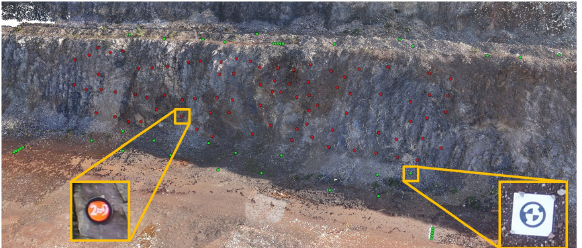
Figure 7: The reference point network allows an extensive accu- racy evaluation. Systematic deformations of the image block and reconstructed object geometry can be quantified. Markers (bot- tom right) indicating GCP positions are shown in green, circular targets (left) for quantitative evaluation are in red.